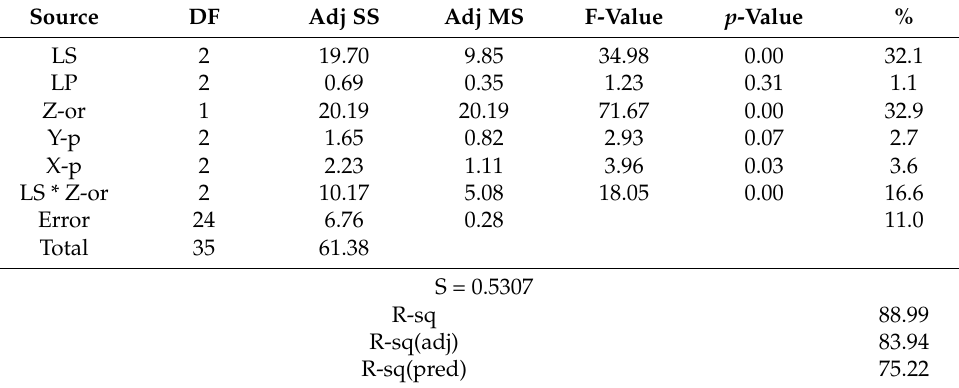
Table 3. ANOVA for the